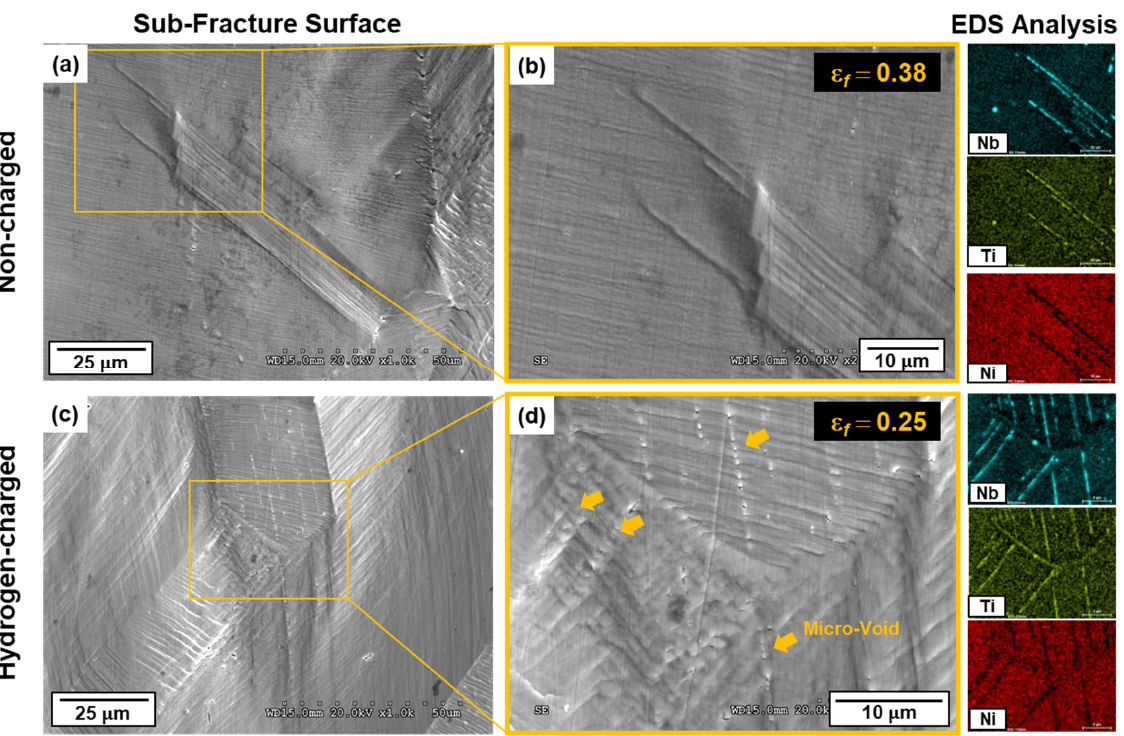
Figure 8. SEM images of the surface area near the fracture surface of ( a , b ) the non-charged and ( c , d ) the hydrogen-charged CG-A specimens, showing incoherent twin boundary and needle-like MC carbide. EDS maps of Nb, Ti, and Ni indicate the position of the needle-like MC carbides in ( b , d ). The yellow arrows in ( d ) indicate the micro-voids at the carbide/matrix interface.